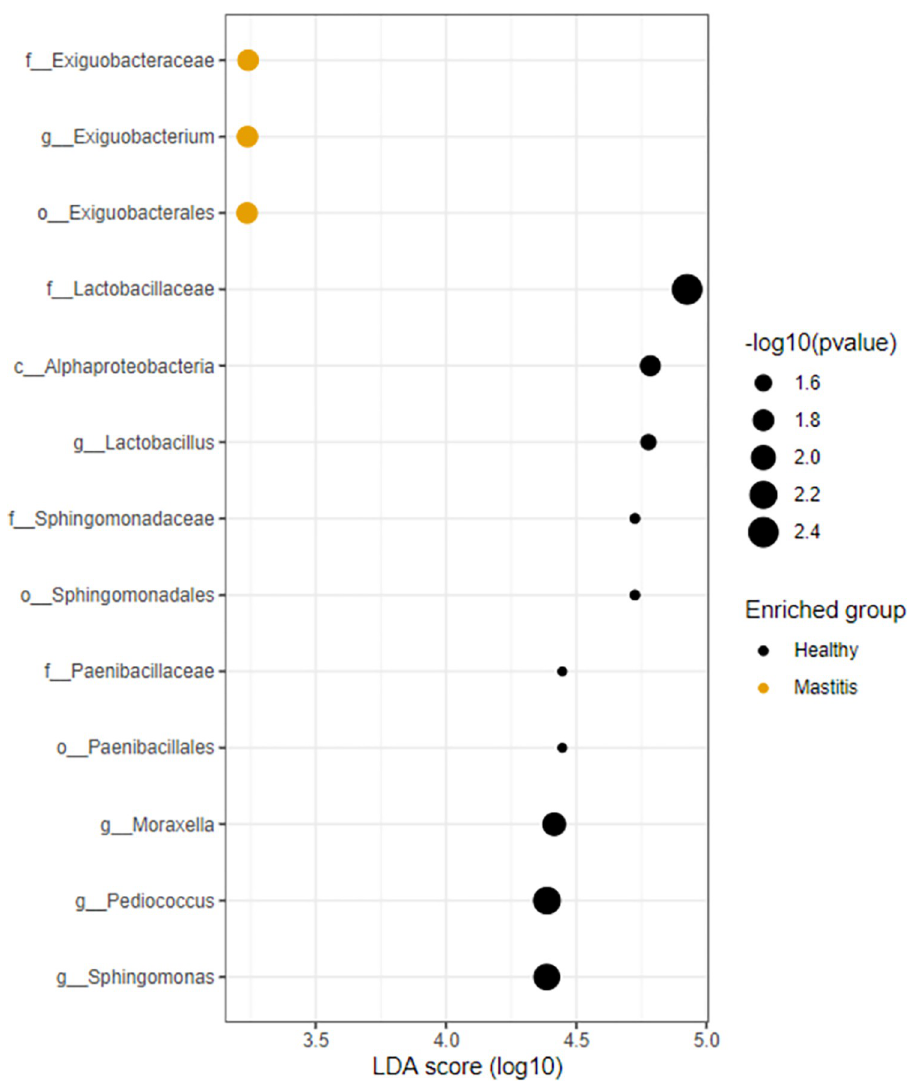
Fig 3. Effect size and statistical significance of the top ten marker per sample group corresponding to healthy and mastitis samples for the 16S